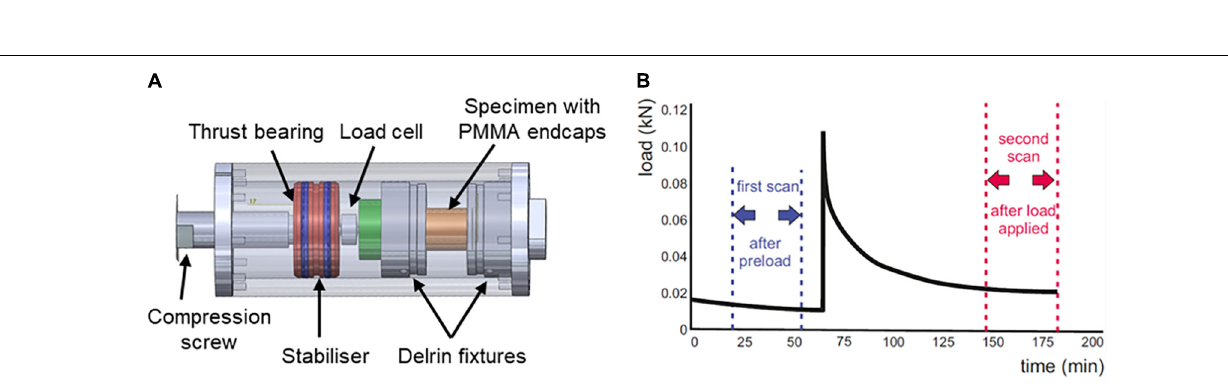
FIGURE 3 | (A) The CT-compatible compression rig. (B) Illustration of the timing of the CT image acquisition, showing the first “preloaded” scan and second scan following load step